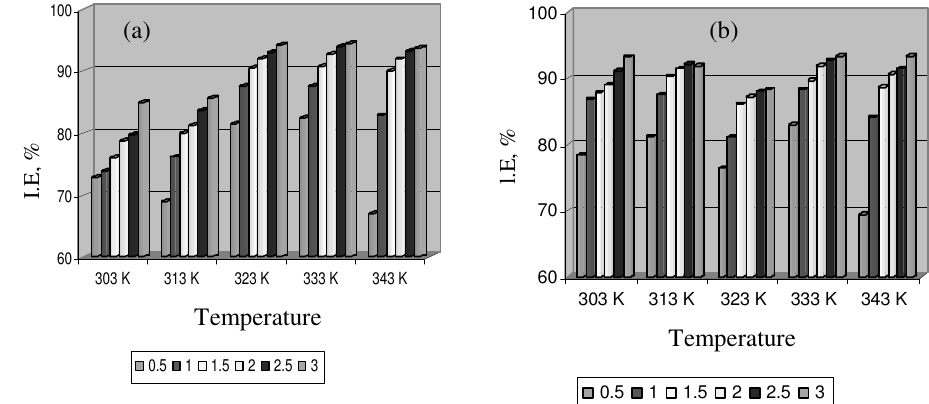
Figure 2. Effect of temperature on the corrosion of mild steel in (a) 0.5 M H (b) 1 M HCl in the presence of various inhibitor